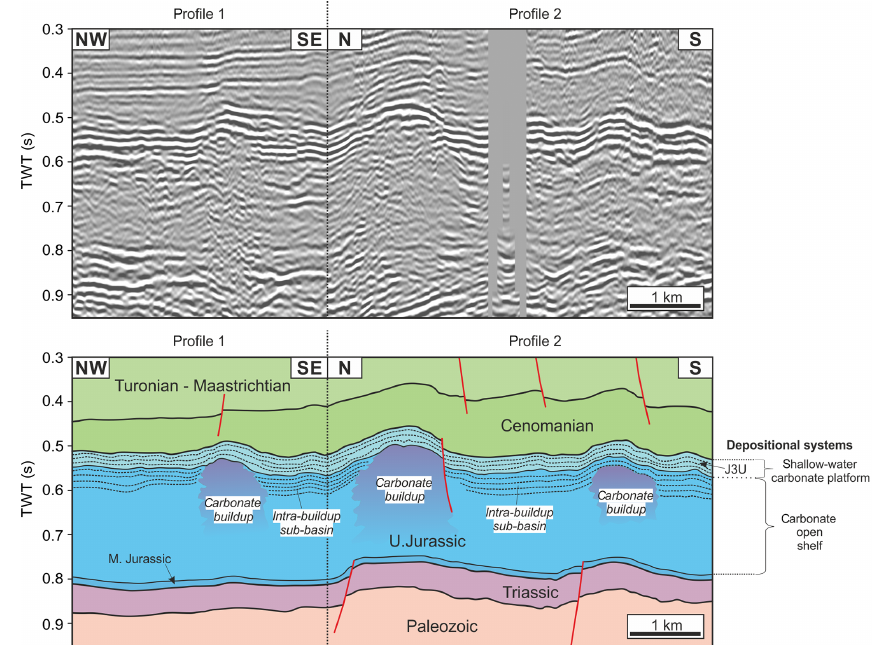
Figure 15. Uninterpreted and interpreted seismic transect (see Fig. 5 for location) showing distinctive elements of depositional architecture of the Upper Jurassic succession in the study area: presence of large carbonate buildup complexes represented by massive facies, and intra- buildup sub-basins represented by bedded